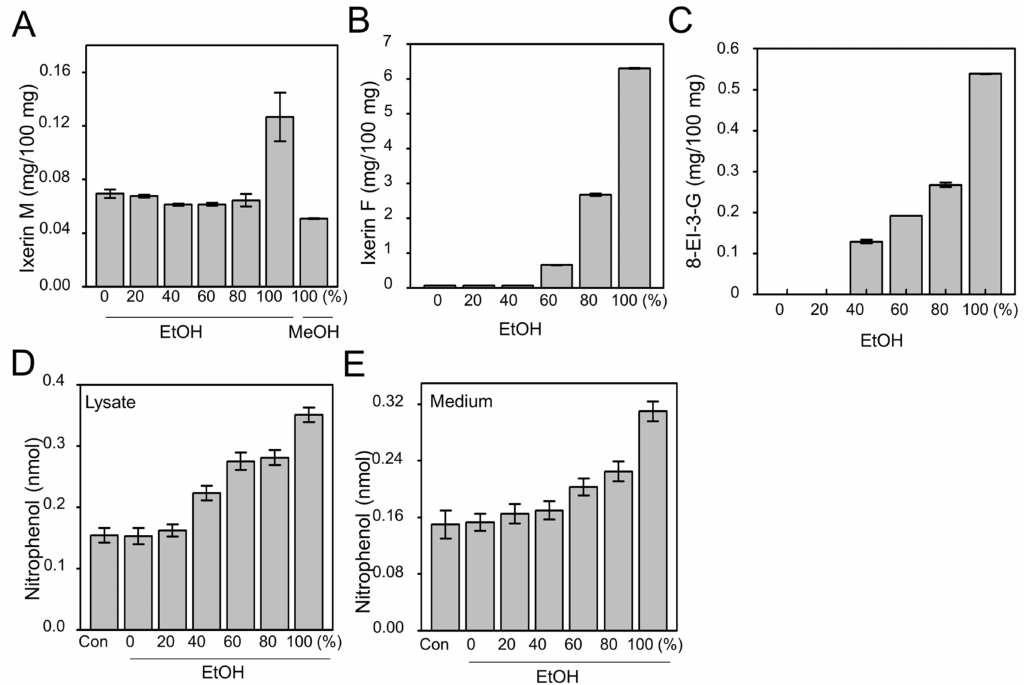
Figure 1. The effect of the different grades of ethanol on extraction of IXD. Purified compounds, ( A ) Ixerin M; ( B ) Ixerin F; ( C ) epiisolipidiol-3- β - D -glucopyranoside (8-EI-3-G) in the IXD extract found by extraction with different grades of ethanol and 100% methanol; ( D , E ) effect of different grades of ethanol on extraction of IXD and measurement of amylase secretion in HSG cells exposed to high glucose concentrations; ( D ) amylase secretion measurement using cell lysates; ( E ) amylase secretion measurement using cell cultured